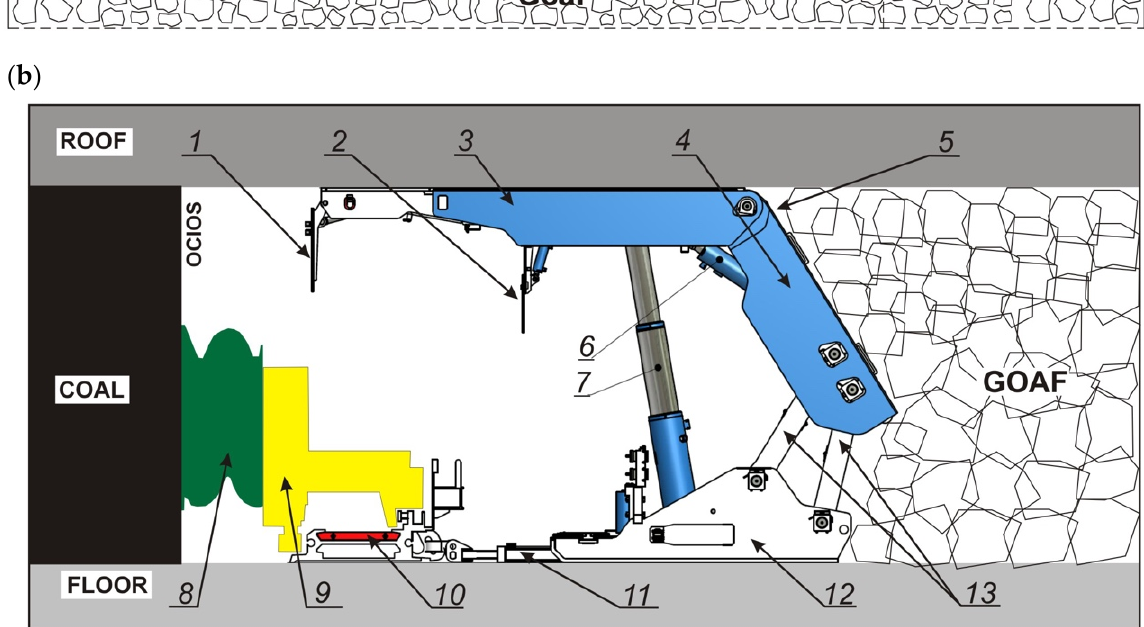
Figure 2. Example of arrangement of basic machinery of a longwall set: ( a ) longitudinal section of a longwall, where: 1— crusher, 2—main gate conveyor, 3—longwall conveyor (chock), 4—longwall shearer, 5—powered roof support, 6—mining direction; ( b ) cross-section of a longwall, where: 1—face shield, 2—transition shield, 3—canopy, 4—shield support, 5— powered roof support, 6—hydraulic support actuator, 7—hydraulic leg, 8—shearer loader, 9—shearer loader, 10—armoured face conveyor, 11—traverse system, 12—floor base, 13—linkage system.